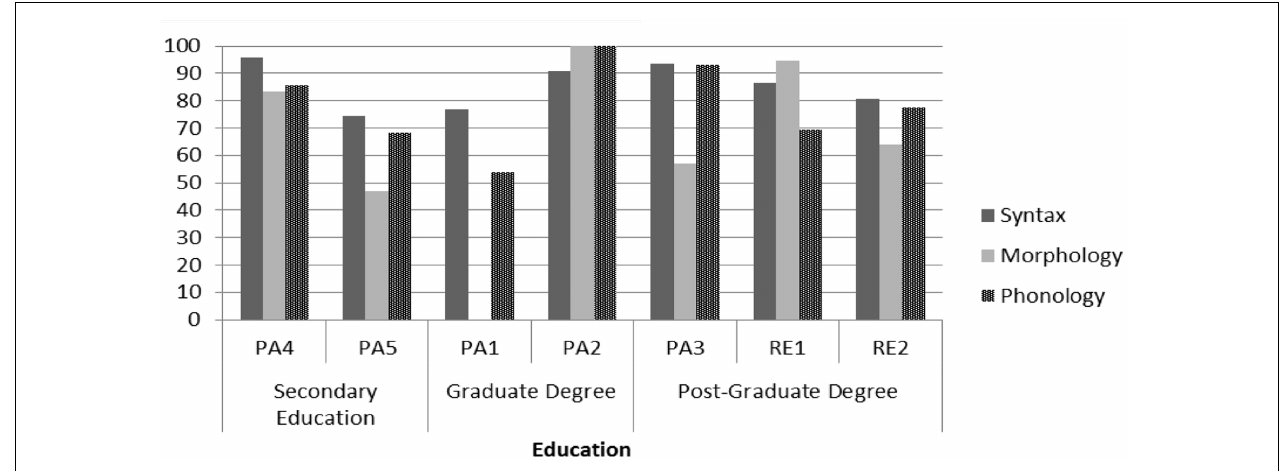
FIGURE 6 | The use of Cypriot Greek variants across participants and levels of education.